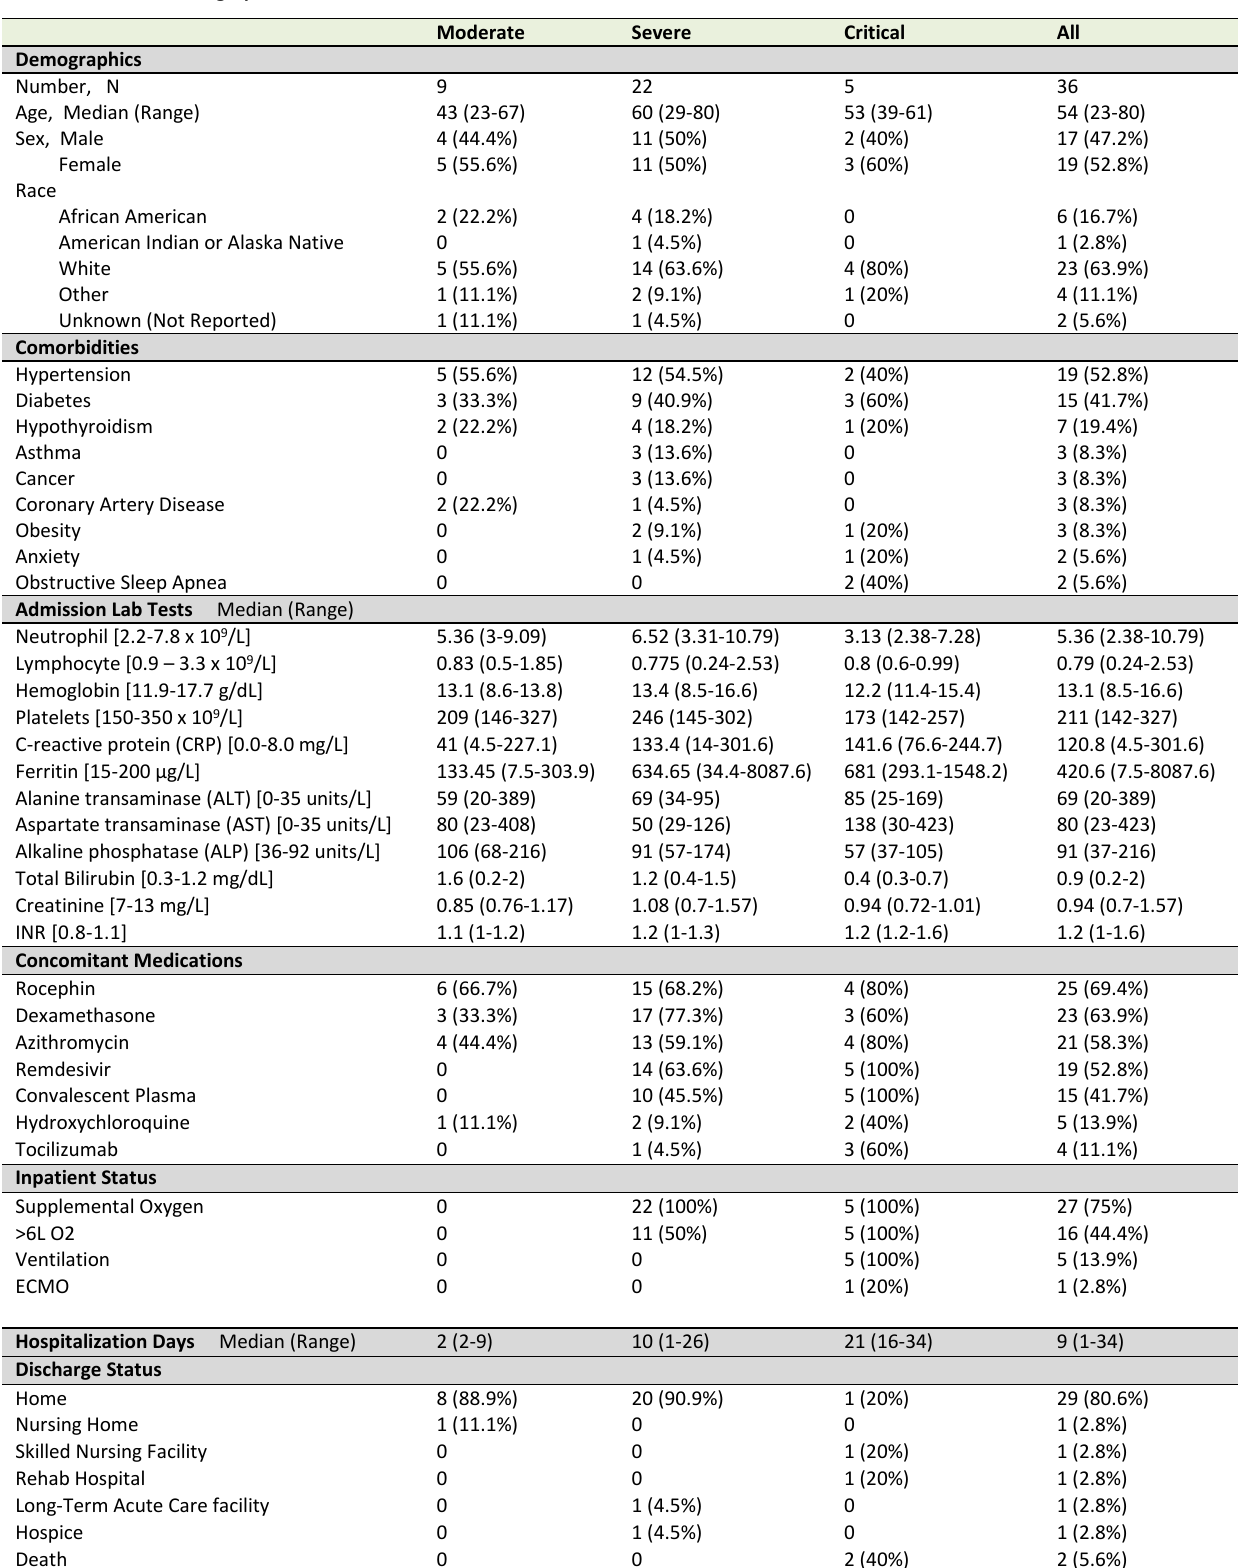
TABLE 1. Patient demographics and clinical